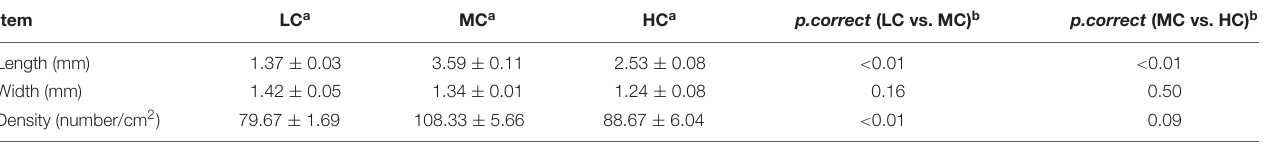
TABLE 2 | Effects of LC, MC, and HC diets on the ruminal papillae characteristics.